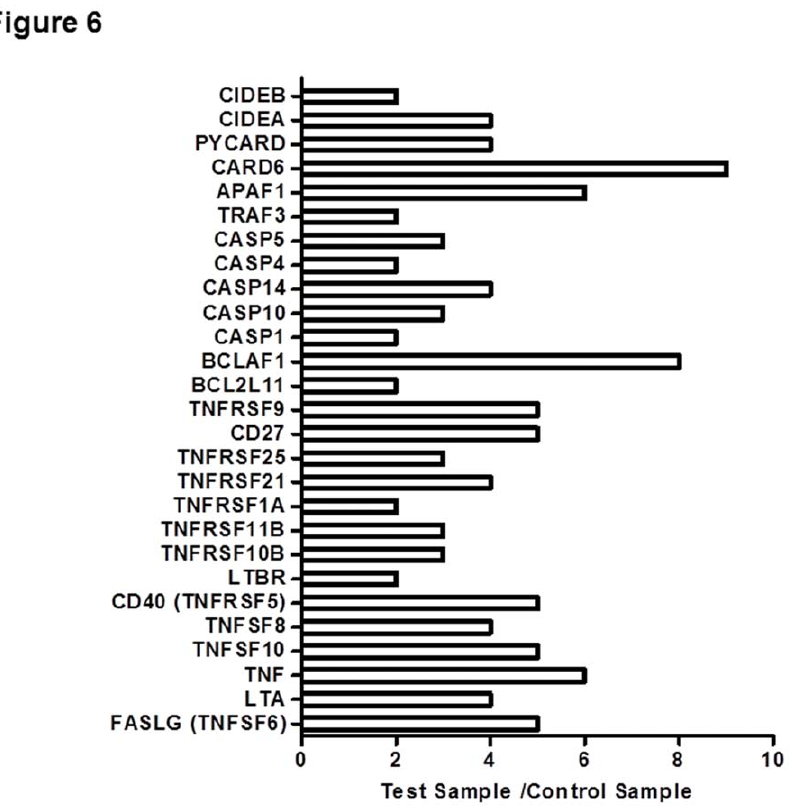
Figure 6. Effects of Osthole on Expressions of Apoptosis-Related Genes. SMMC-7721 cells were treated with osthole (123.0 m M) for 48 h. The expressions of apoptosis-related genes were analyzed using RT 2 Profiler PCR Arrays. Increased expressions of two folds or more were shown. Data shown were representatives of two experiments.